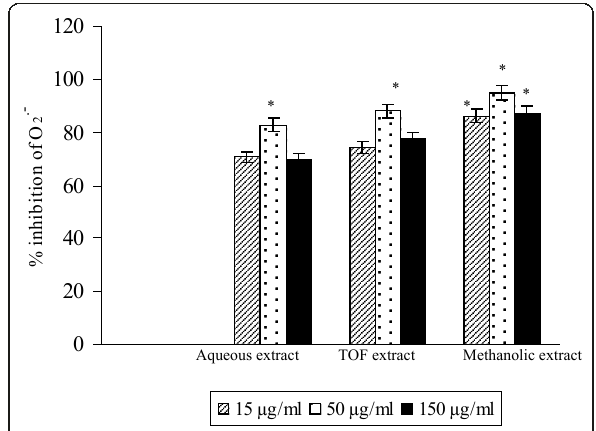
Figure 1 Scavenging effects of extracts of Acacia salicina against X/XOD-generated superoxide free radicals (O 2 · - ) . * P <0.05